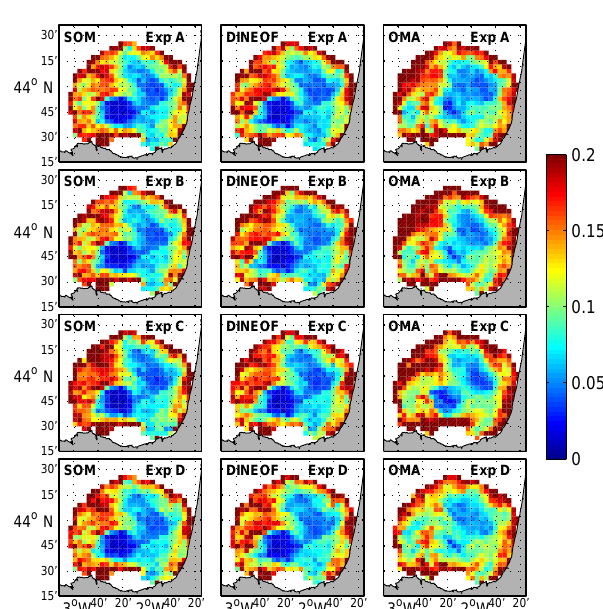
Figure 15. Maps of the time average of the pixel-by-pixel absolute relative error of the RT computed from the three filled velocities with respect to RT obtained from the reference velocity